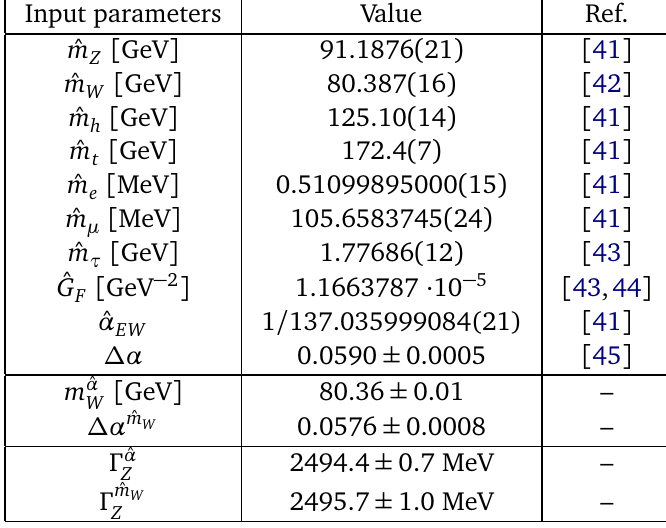
as W scheme. The Z widths are W